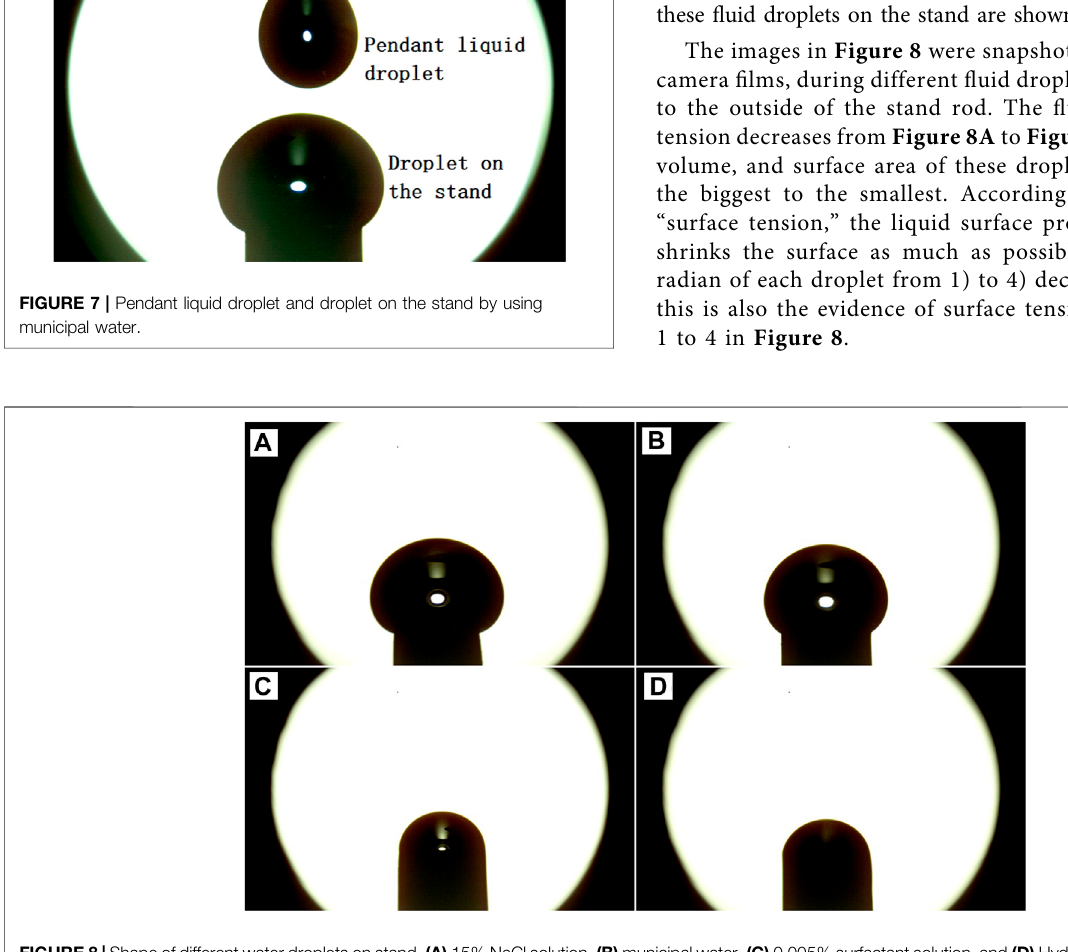
Frontiers in Environmental Science |